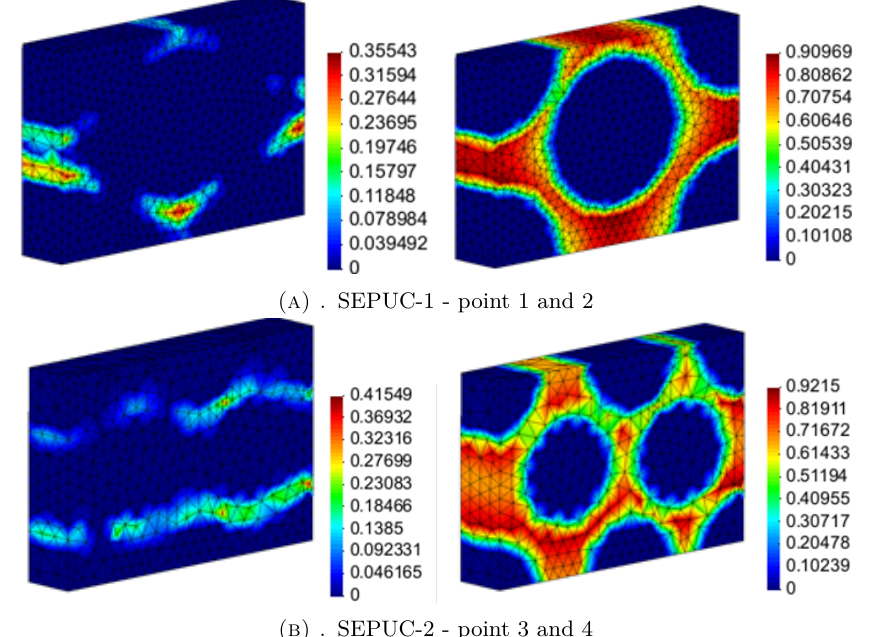
Figure 6. Damage evolution in the matrix corresponding to the marked numbered points in Fig. 5.